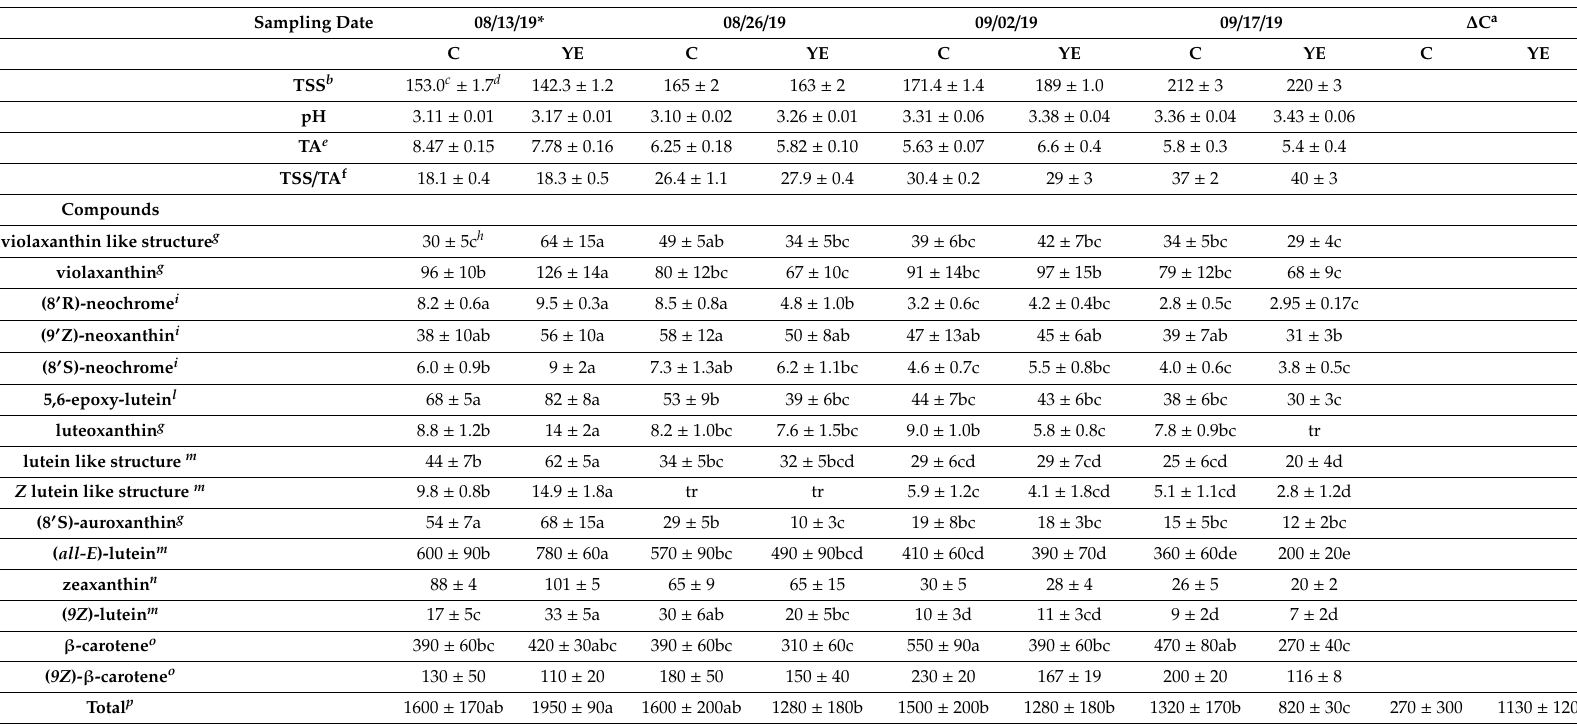
Table 2. Changes in carotenoid contents (expressed as µ g / kg of berries) in Negro Amaro grapes from v é raison to